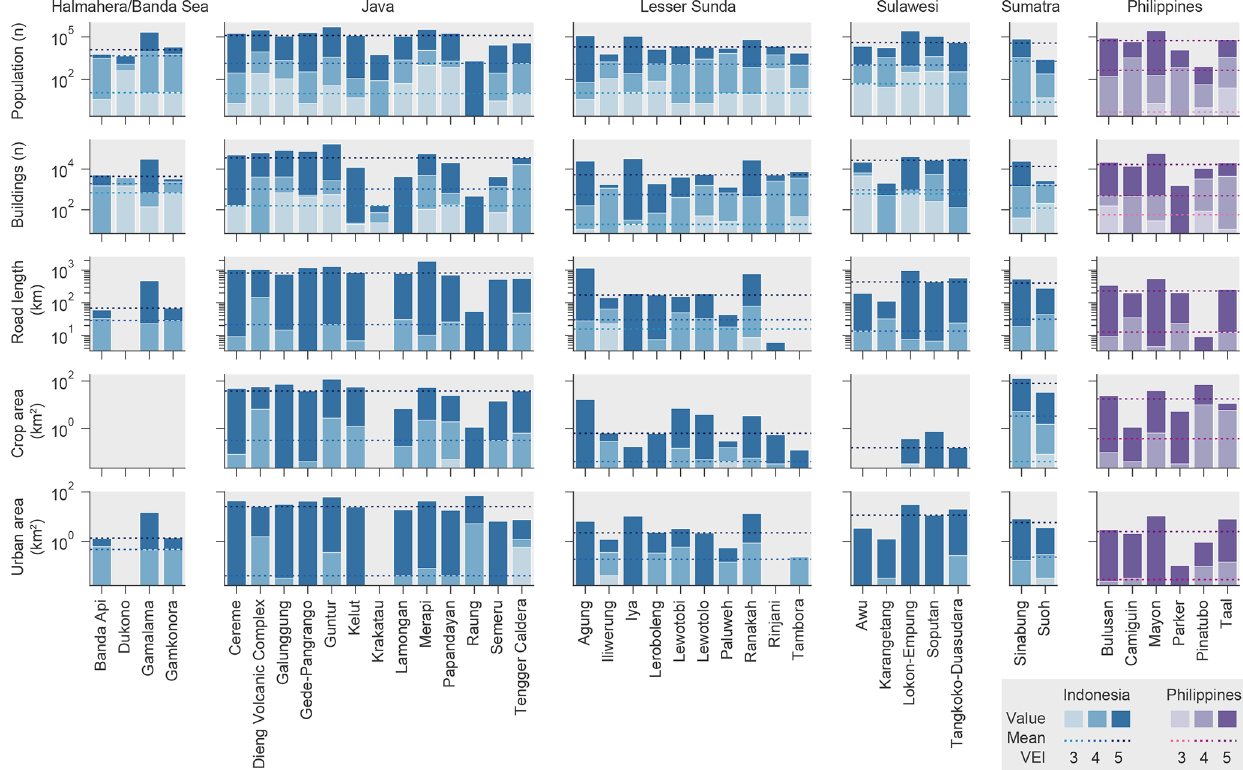
Figure 7. Exposure to the large clast hazard (i.e. hazard caused by a kinetic impact ≥ 30J) summarised per region and exposure type for a conditional exceedance probability of occurrence of 50%. Overlying (not stacked) bars illustrate the variability in exposure with VEI (with the top of the bar representing exposure for that VEI) and dotted lines the median for the